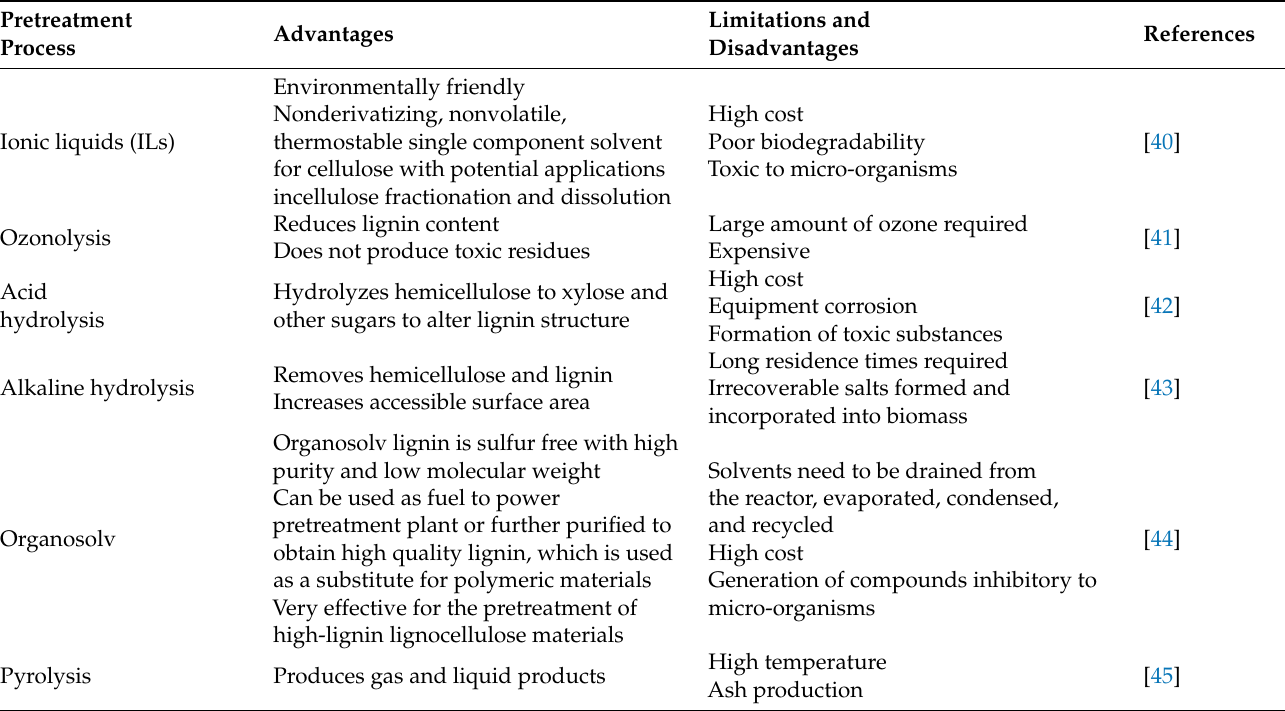
Table 1. Advantages and disadvantages of various chemical pretreatment